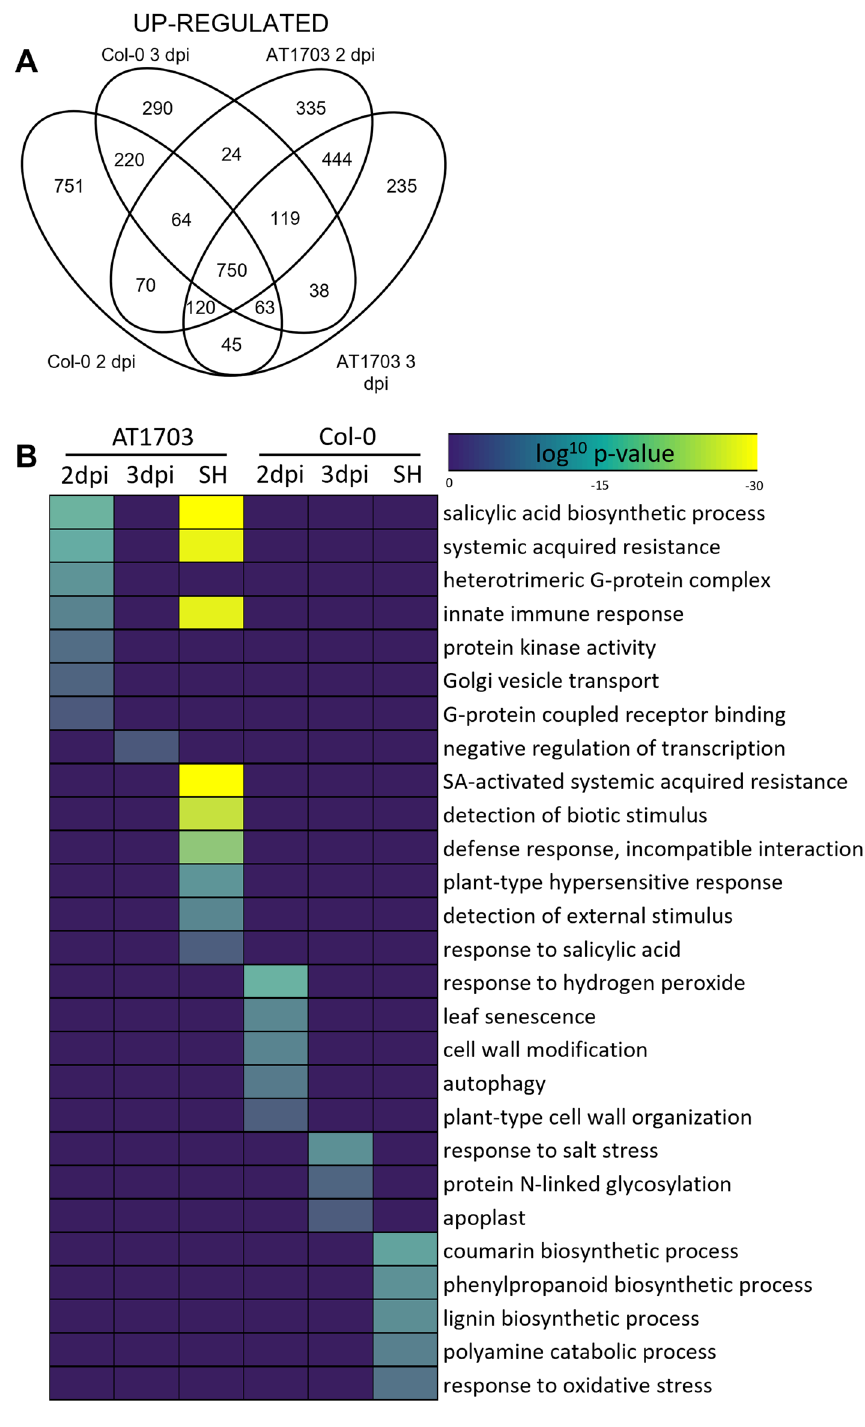
Figure 3. Identification of differentially expressed genes and enriched GO terms in response to S. sclerotiorum infection in wild-type Col-0 and AT1703. ( A ) Venn diagram representing up-regulated genes in infected wild- type Col-0 and AT1703 A. thaliana . ( B ) Heatmap of enriched GO terms associated with shared up-regulated gene patterns. GO terms considered statistically significant with a hypergeometric log10 p-value < 0.001. SH